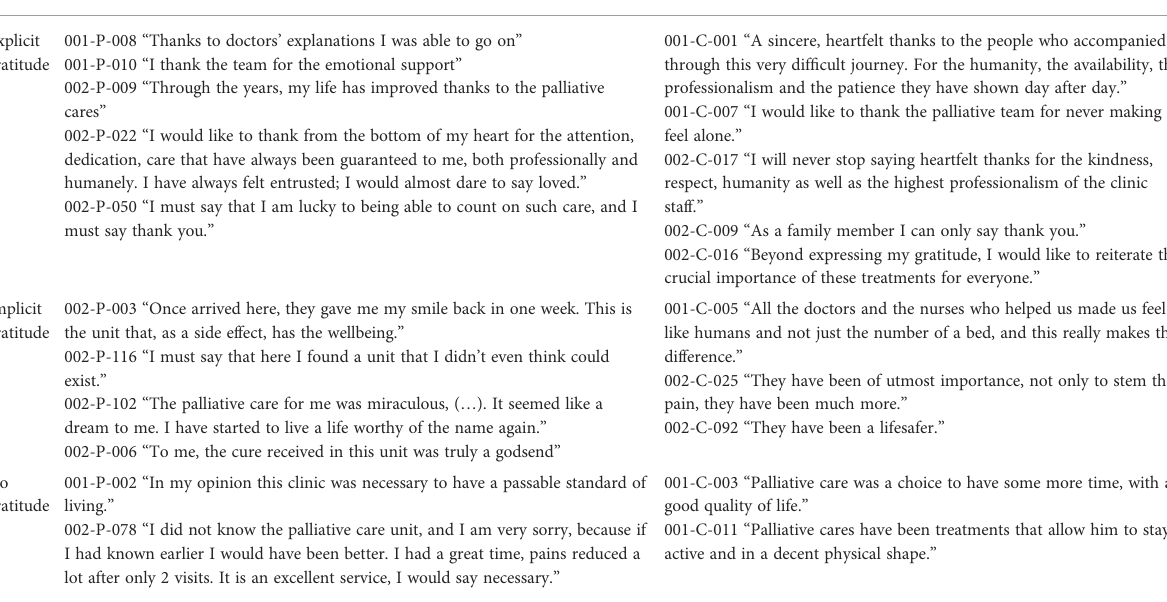
TABLE 3 Quotations of explicit, implicit, and no gratitude from patients and caregivers. Patients Caregivers